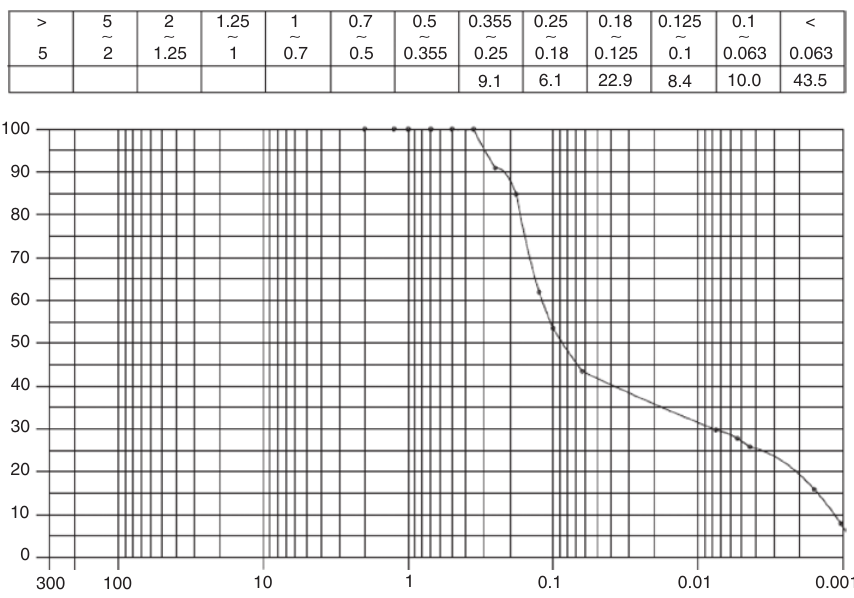
Figure 2: Particle size distribution of Pb(NO